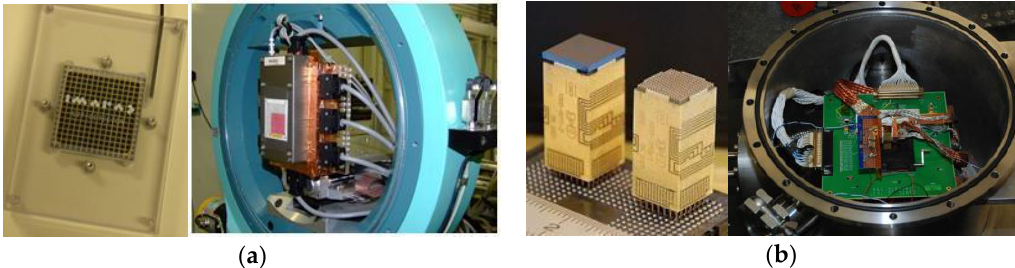
Figure 3. The pixel prototype used for the PolCA experiments at European Synchrotron Radiation Facility (ESRF) (ID15A): ( a ) The IMARAD two-dimensional (2D) CZT sensor (left), the PolCA-IMARAD detection system at the beamline inside its room temperature light tight container (right); and, ( b ) The Caliste-256 Module with the 1 mm thick Schottky CdTe (right), and the Caliste module mounted on its electrical and mechanical interface inside the thermo-vacuum container ( T ∼ −10 °C).